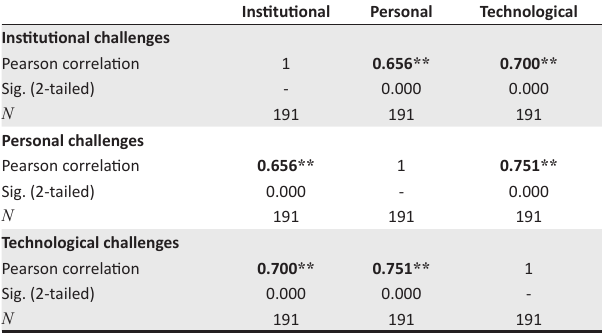
TABLE 2: Factor loadings.